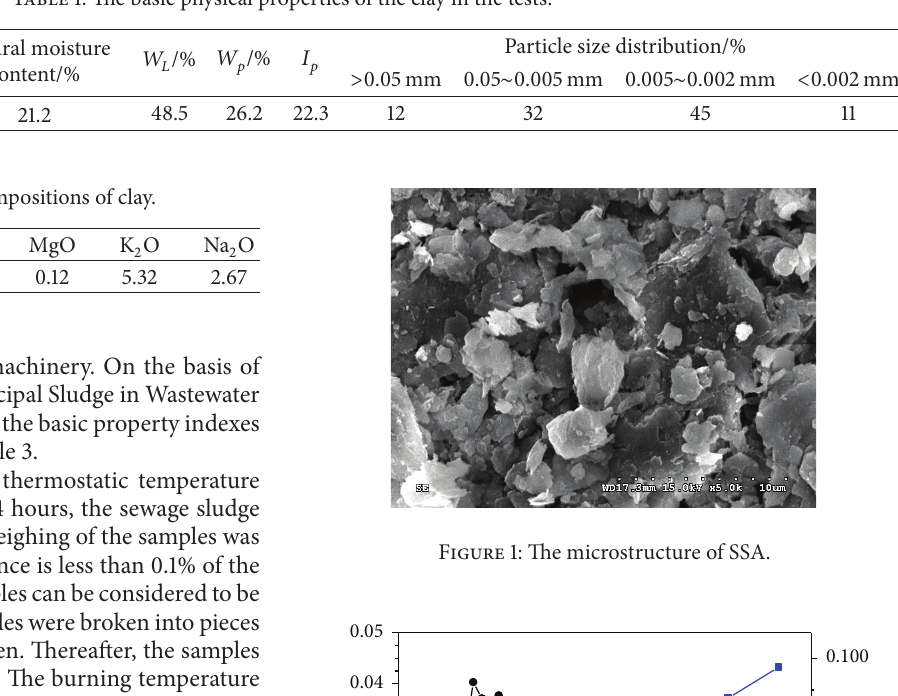
Table 1: The basic physical properties of the clay in the tests.